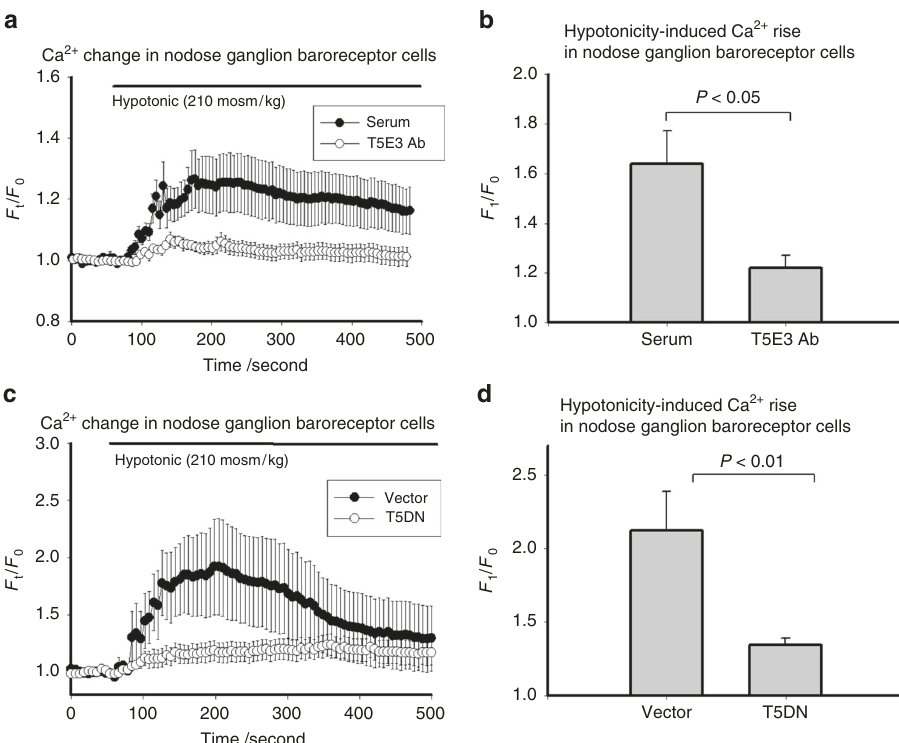
Fig. 3 Hypotonicity-induced [Ca 2+ ] i rise in rat baroreceptor neurons is inhibited by T5E3 and T5DN. a and c Representative time-series graphs for [Ca 2+ ] i fl uorescent signal in primary cultured DiI-positive neurons from rat nodose ganglia in response to hypotonicity (210 mOsm). The data points represent the mean ± s.e.m. for ≥ 7 cells in a representative experiment ( n = 6). b and d Summarized mean ± s.e.m. ( n = 6 separate experiments) data for the maximal [Ca 2+ ] i increase (F 1 /F 0 ) in response to hypotonicity (210 mOsm) as in a and c , respectively. In a and b , cells were pre-incubated with a TRPC5-blocking antibody T5E3 (4 μ g ml − 1 ) or pre-immune IgG (4 μ g ml − 1 , labeled as “ pre-immune ” ) for 15 min. In c and d cells were transfected with 5 µ g dominant- negative TRPC5 (T5DN) or pCDNA6c (vector) by